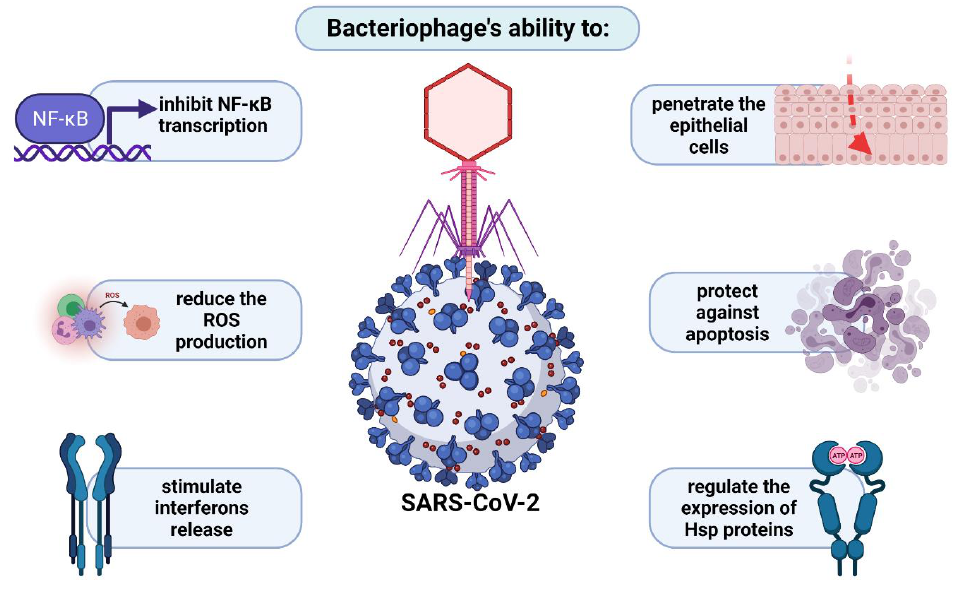
Figure 4. Bacteriophage potential in treatment of SARS-CoV-2 infections.